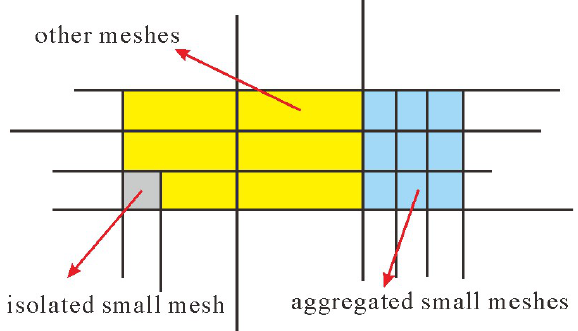
Figure 1. Mesh classification.